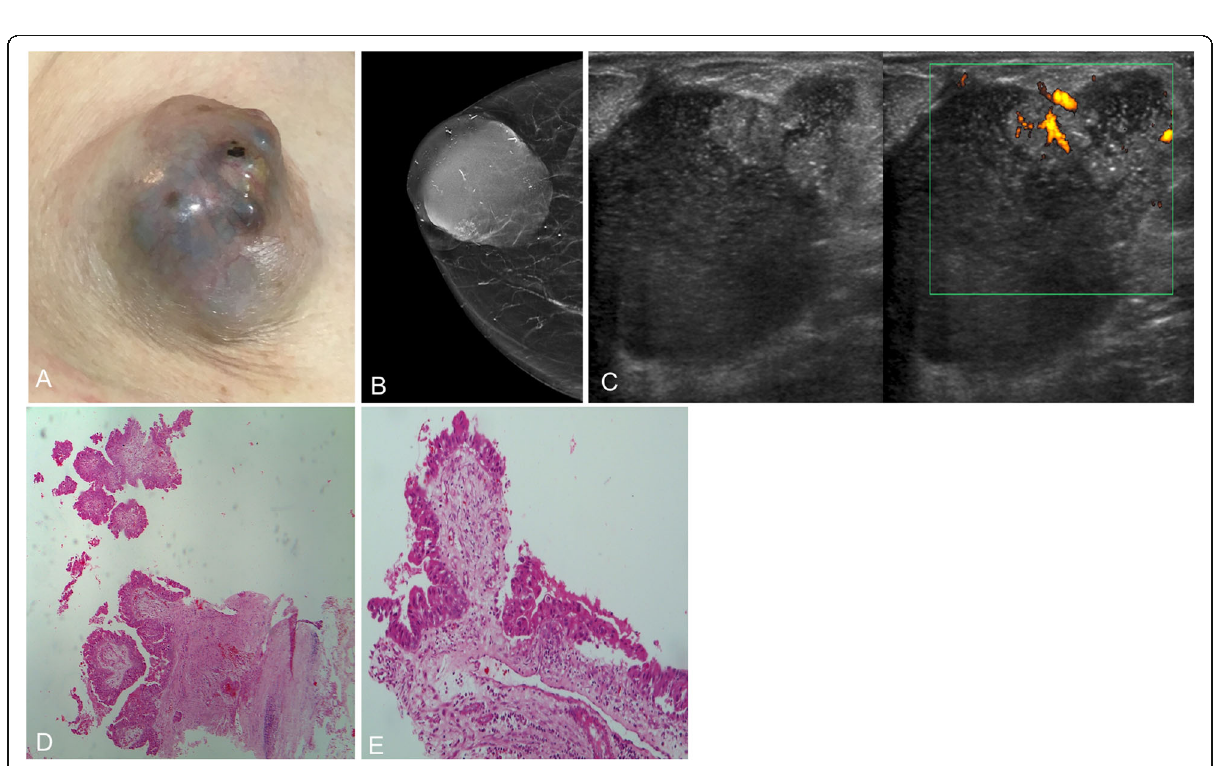
Fig. 34 Ductal carcinoma in situ. a Photograph of an 85-year-old woman with a large palpable retroareolar mass with marked involvement of the right nipple- areolar complex. b Synthesized 2D mammogram shows a circumscribed retroareolar mass with associated pleomorphic calcifications. c Ultrasound shows a cystic mass with debris inside and a solid mural nodule with a penetrating vessel in the power-Doppler study. d Hematoxylin-eosin stain (×10). Fragment of the cyst wall with slight chronic inflammatory involvement and vascular congestion and epithelial lining made up of few layers of markedly pleomorphic elements and dense eosinophilic cytoplasm. Note the proliferation of the papillary pattern, with fronds with wide fibroconnective stems lined with similar pleomorphic elements (intraductal carcinoma within the cyst). e Close-up (Hematoxylin-eosin stain